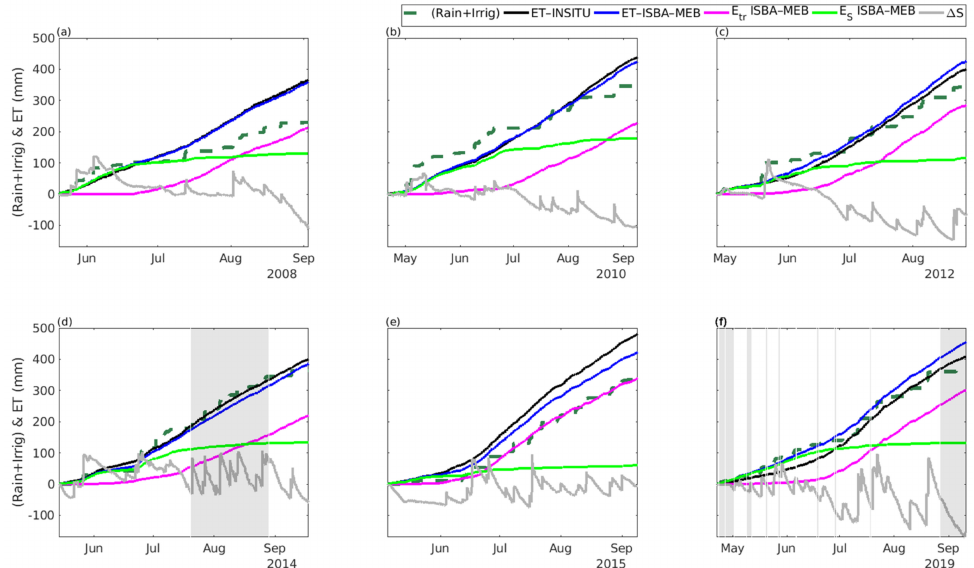
Figure 11. Comparing the cumulated rainfall (+irrigation) with evapotranspiration (ET) from field measurements and ISBA-MEB estimates with plant transpiration (E tr ), soil evaporation (E S ), and soil water storage ( ∆ S) for the maize seasons at FR-Lam site. The grey area in the chart represents periods without soil water measurements and periods substituted with ISBA-MEB